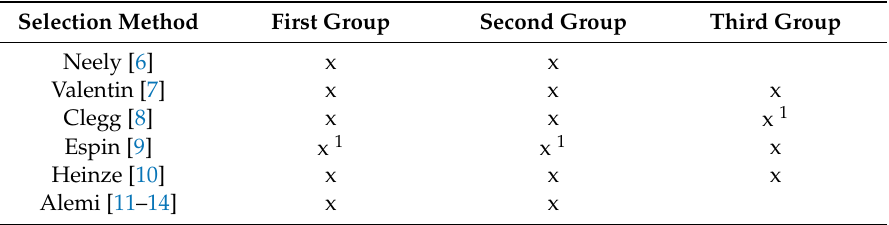
Table 1. Group of parameters by selection